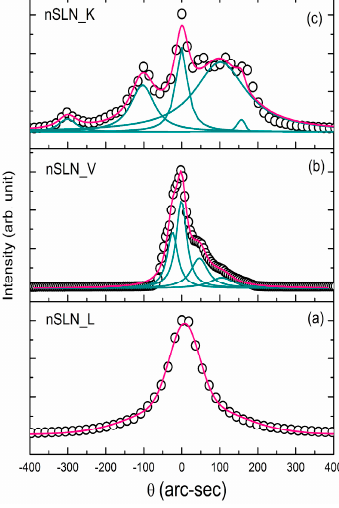
Figure 6. HRXRD curves of ( a ) SLN_L; ( b ) SLN_V; and ( c ) SLN_K crystals.